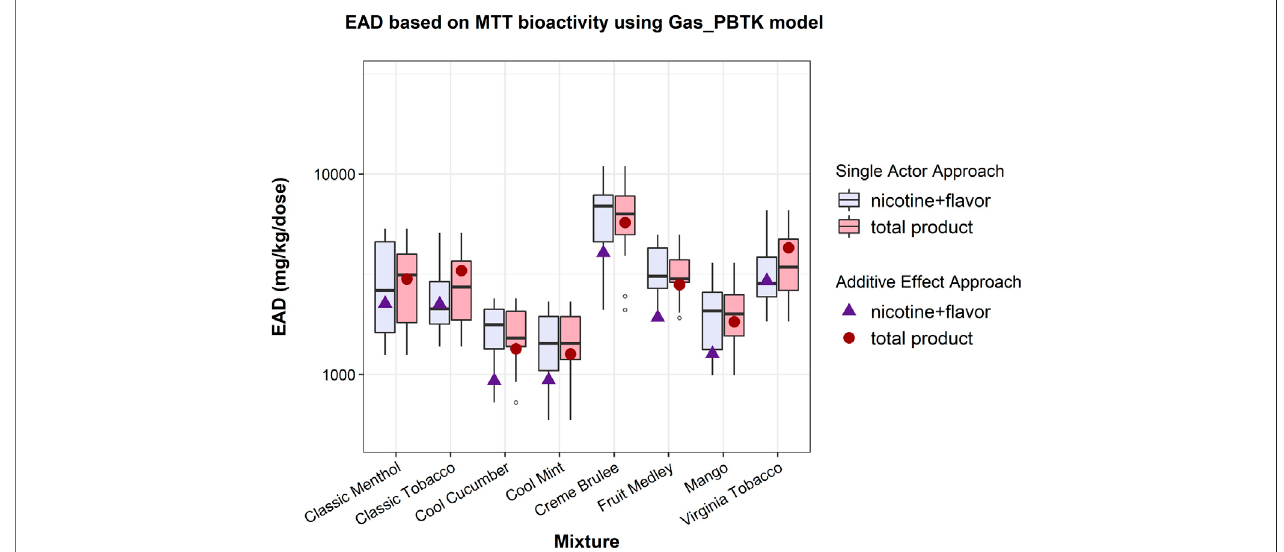
FIGURE1| EADestimatesforthebioactivityofe-liquidsbasedontheMTTassayusingdifferentassumptionsaboutcontributorstobioactivityunderboththesingle actor and additive approaches. “ Total product ” (shown in red) assumes all e-liquid ingredients (including PG, VG, and BA) contribute to bioactivity, while “ nicotine + fl avor ” (shown in blue) assumes only nicotine and fl avors contribute to bioactivity. Box plots show distributions of results across all ingredients using the single actor approach while points (solid triangles and circles) show the point estimate for EAD using the additive effect approach.